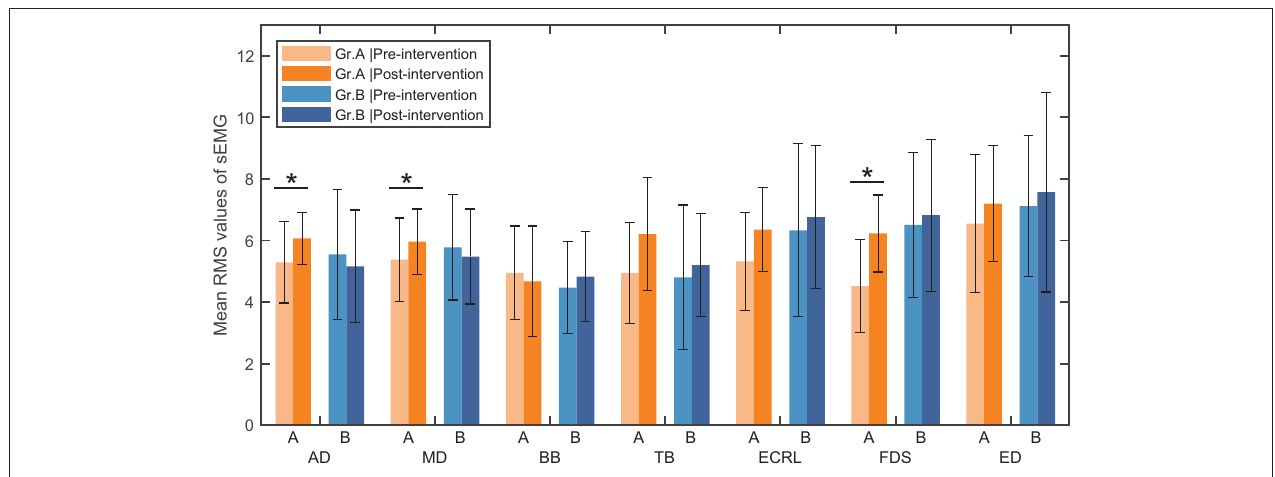
FIGURE 3 | Mean RMS value of sEMG signal in seven muscles and standard deviation across each group (Group A or Group B). AD, anterior deltoid; MD, middle deltoid; BB, biceps brachii; TB, triceps brachii; ECRL, extensor carpi radialis longus; FDS, flexor digitorum superficialis; ED, extensor digitorum; Gr.A, Group A; Gr.B, Group B. *Significance level P <